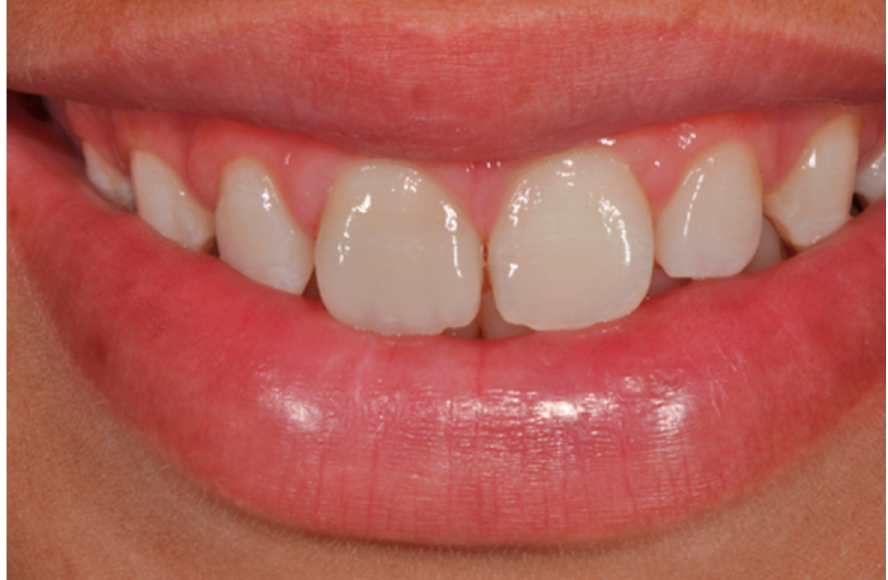
Figure 15. Three months post-operative. Reprinted from Restauri diretti nei settori anteriori, G. Paolone, S. Scolavino, © 2021, with permission from Quintessence Publishing Italy.